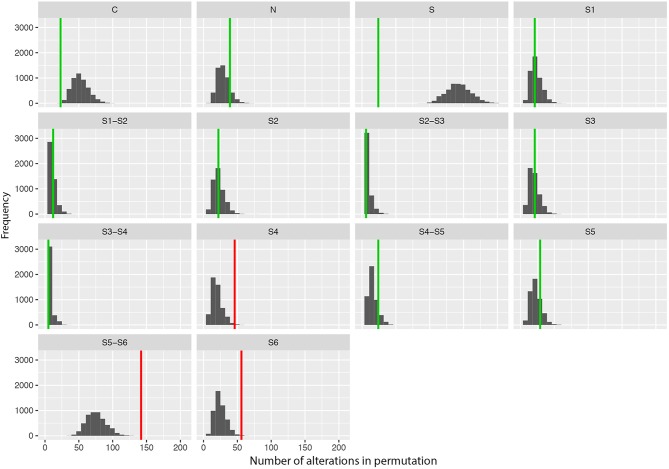
Results of the permutation test for the number of changes per segment showing the frequency of missense variants found in patients with Dravet syndrome per segment in 5,000 permutations of data. Vertical lines indicate the observed values (green: adjusted p-value α > 0.10; red: adjusted p-value α > 0.05).